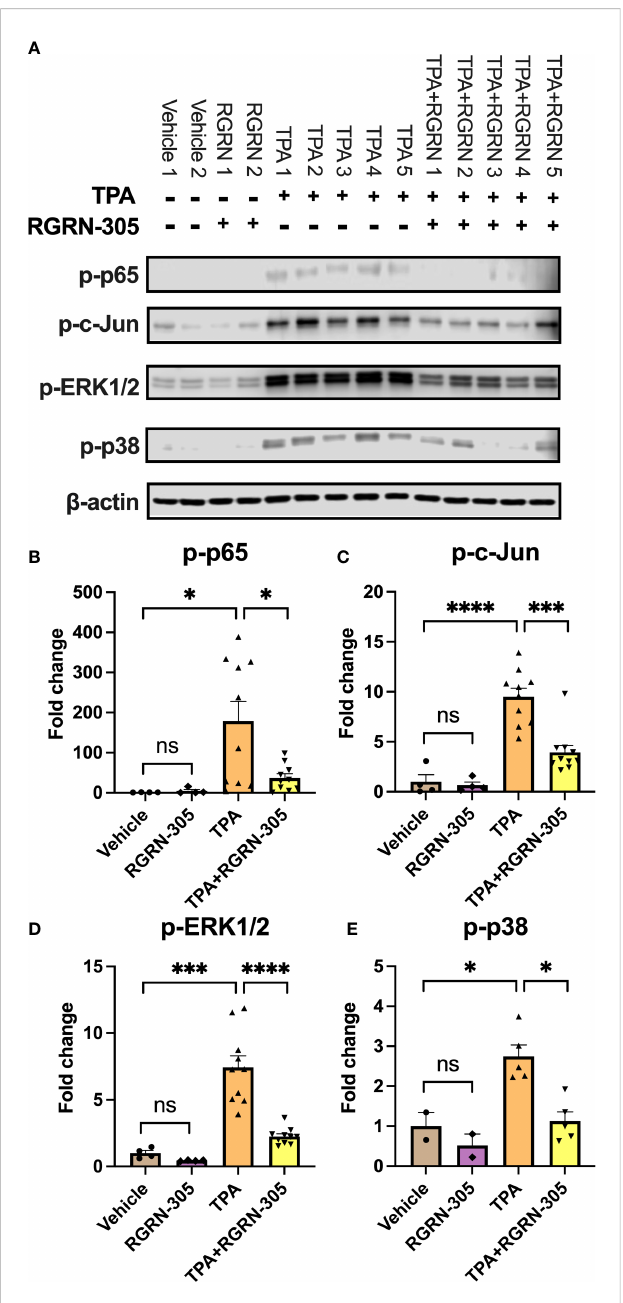
FIGURE 6 Effects of RGRN-305 on the phosphorylation status of key signaling molecules in mice challenged with TPA post 4 hours. (A) Representative Western blots and densitometric analyses of p-p65 (B) , p-c-Jun (C) , p-ERK1/2 (D) and p-p38 (E) . b -actin was used as a loading control. Four to ten mice per treatment group. Data are shown as mean ± SEM fold change relative to vehicle. *p < 0.05, **p ≤ 0.01, ***p ≤ 0.001, ****p ≤ 0.0001. ns, not signi fi cant. TPA, 12-O-